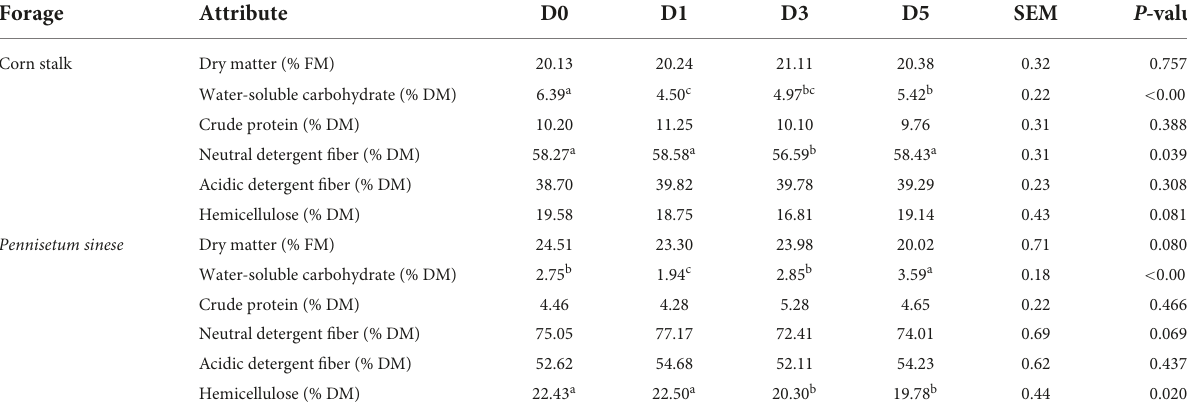
TABLE 2 Chemical composition of corn stalk and Pennisetum sinese silages after 45 days of ensiling. Forage Corn